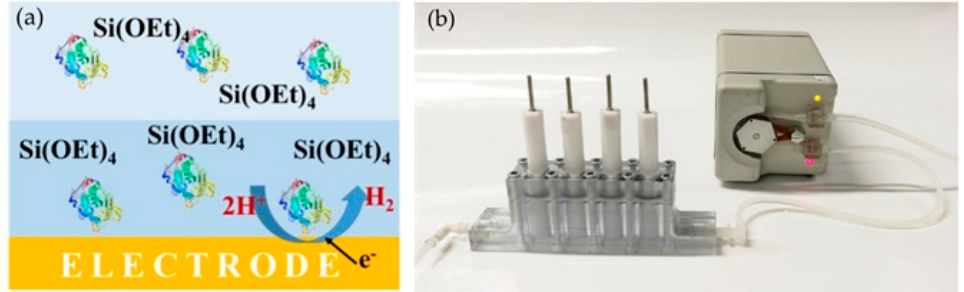
Figure 10. ( a ) Schematic diagram of the electrodeposition of a silica layer with entrapped enzyme on an electrode and ( b ) an image of the continuous flow reactor [107].